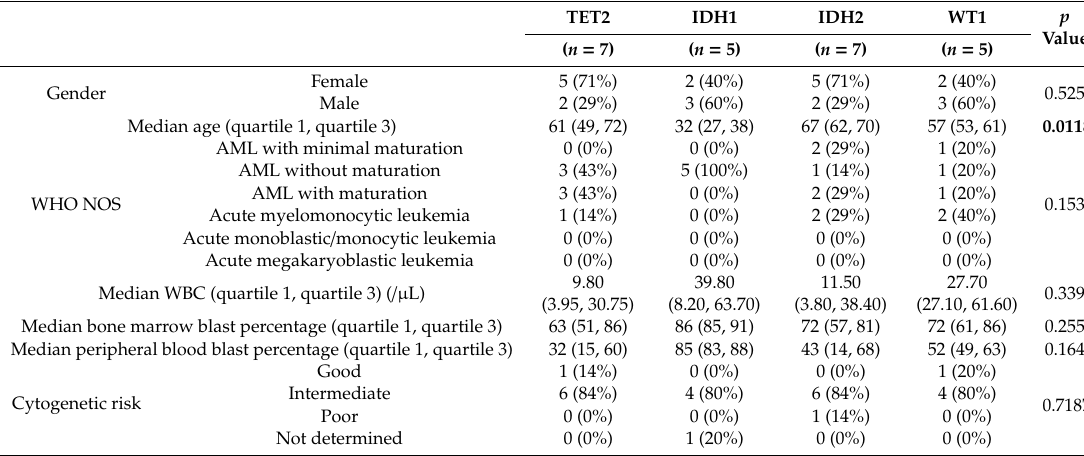
Table 2. Clinical di ff erences between di ff erent hypermethylating mutations (bold numbers are statistically significant